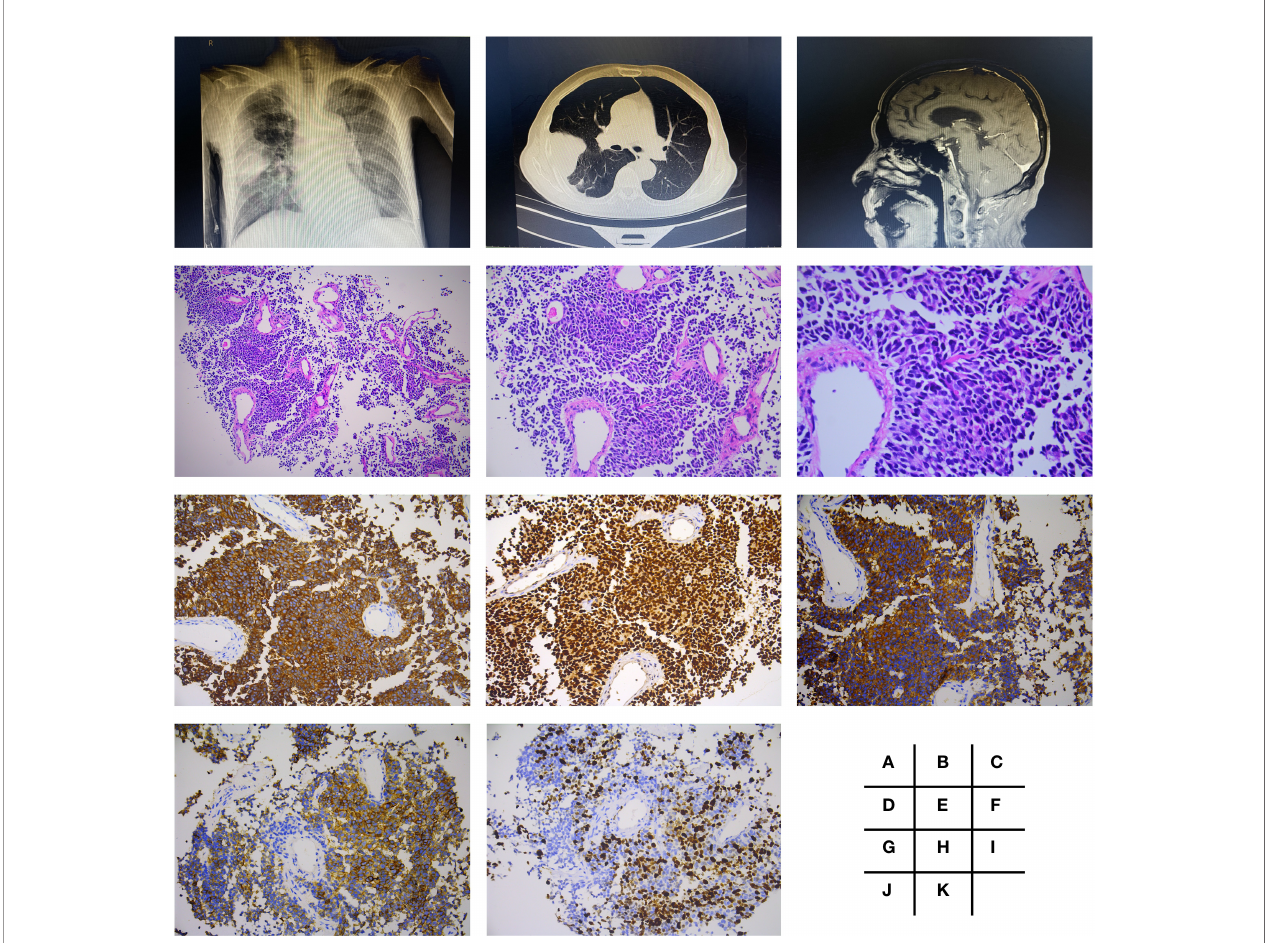
FIGURE 1 | Radiologic fi ndings and histological features of small cell lung cancer (poorly differentiated neuroendocrine carcinoma). Chest X-ray examination showed a mass of high density in right middle lobe (A) , which was presented more clearly by CT (B) . Brain MRI con fi rmed metastasis in cerebellar tonsillar (C) . H&E staining performed is shown in panels (D – F) , which were magni fi ed by ×100, ×200, and ×400, respectively. Further immunohistochemistry staining showed CK7(+) (G) , TIF-1 (+) (H) , SYN(+) (I) , CD56(+) (J) , and ki-67 (60% +) (K) , all with magni fi cation of